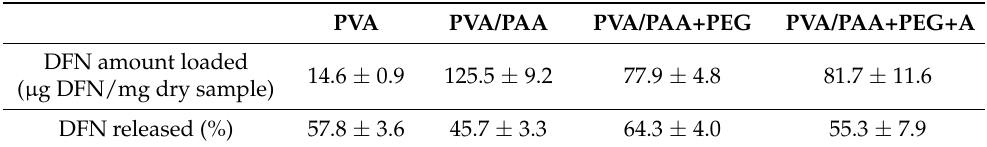
Table 1. DFN loading capacity into the samples and percentage of drug released (average val- ues ± standard deviations, n =